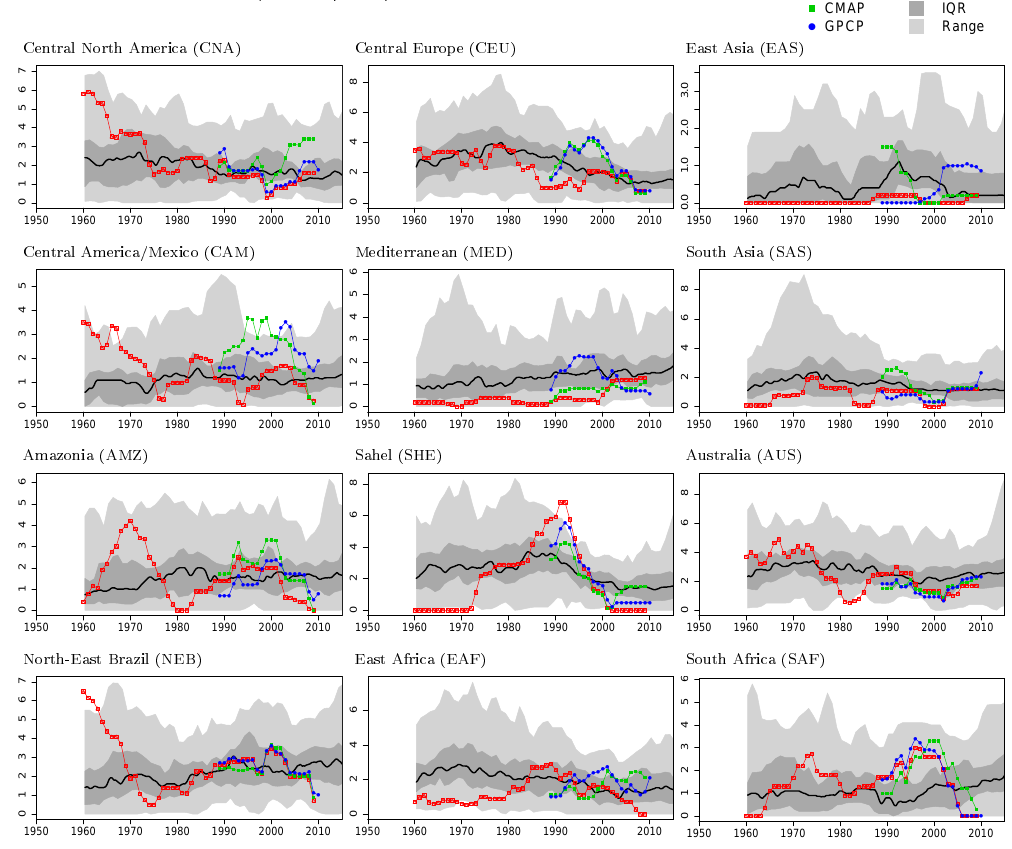
Fig. 4. As Fig. 3, for the occurrence frequencies of “mild drought” (SPI12 < − 0.5) in observation-based datasets and CMIP5 simulations, derived from 10yr moving windows. Frequencies are given as months per